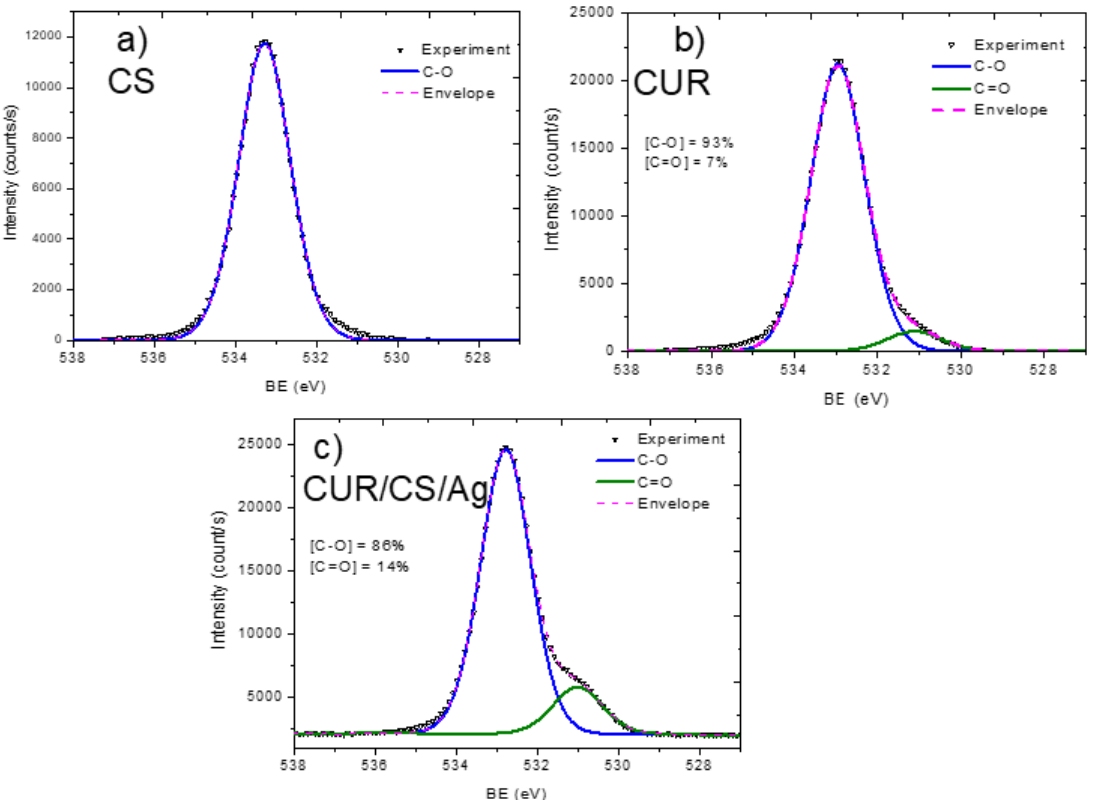
Figure 5. XPS O1s curve fitting of CS ( a ), CUR ( b ), and CS-CUR-Ag ( c ) samples.